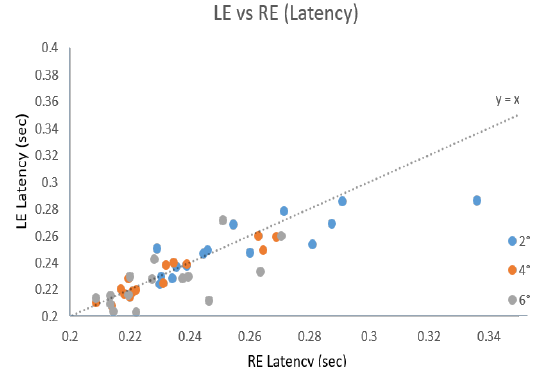
Figure 5: The effect of stimulus target type for the left-eye and right-eye movement response latency for the 2° foveal cross, and the 4° and 6° parafoveal eccentric circles targets stimulating 4° symmetrical vergence step